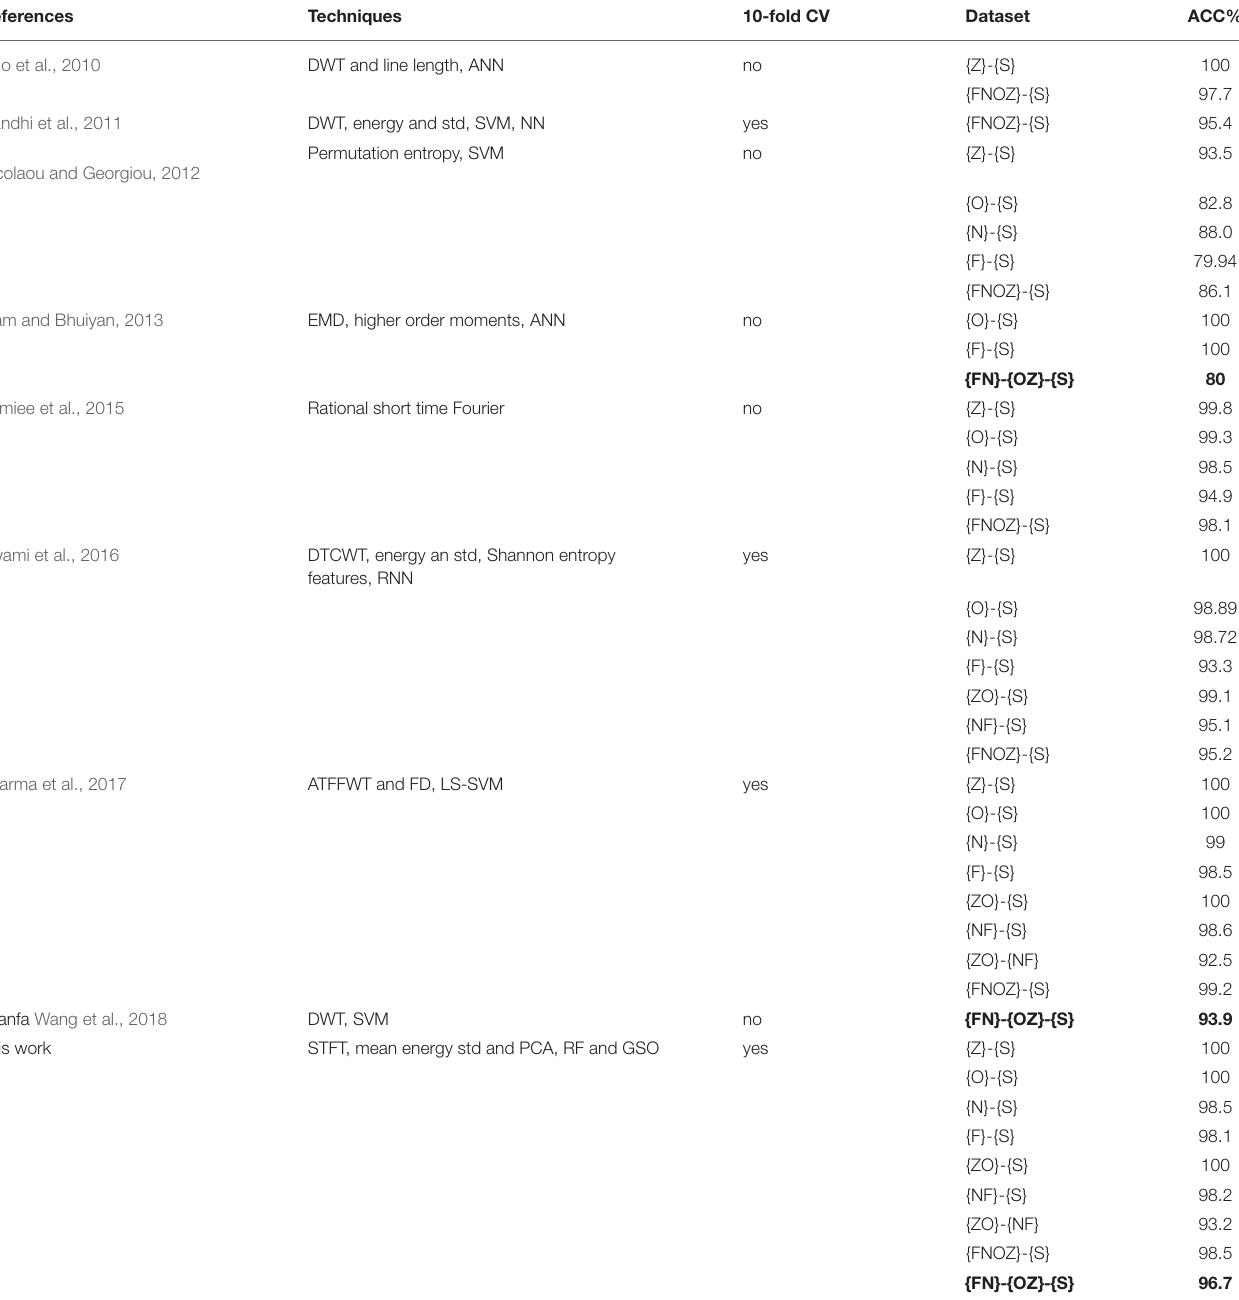
TABLE 3 | Comparison of the main relevant previous research